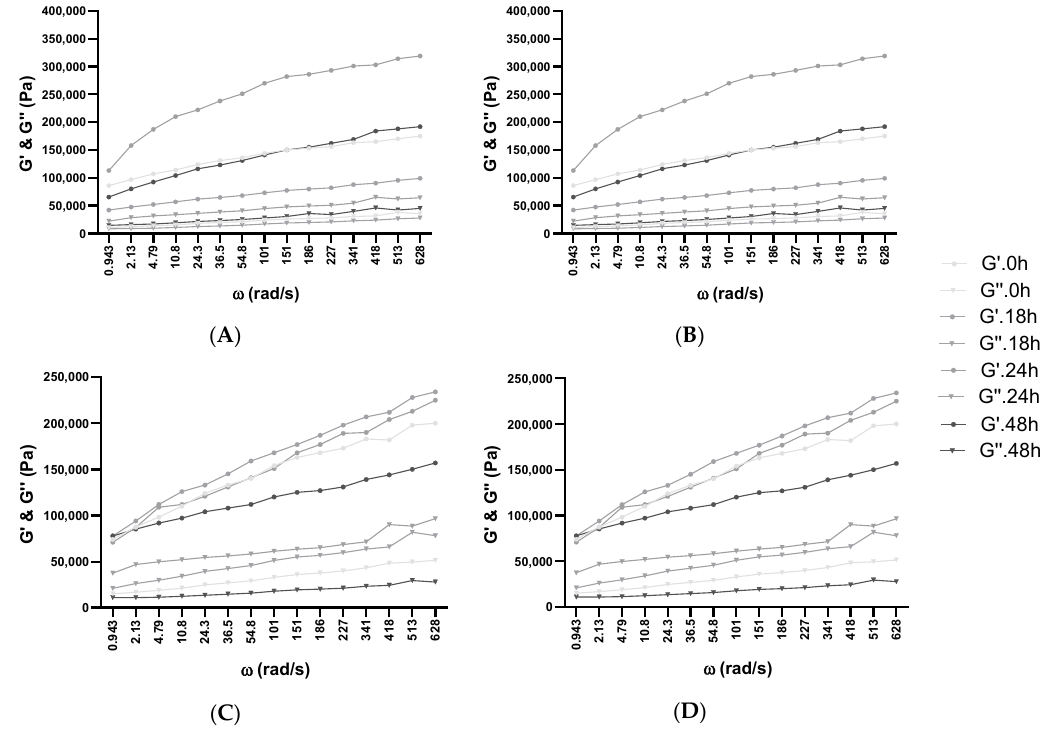
Figure 3. Influence of fermentation and frozen storage with BB-12 in fresh samples—( A ) 5% Glu; ( B ) 5% XOS—and after frozen storage—( C ) 5% Glu; ( D ) 5% XOS. Angular frequency ( ω ), storage modulus (G’), loss modulus (G’’).